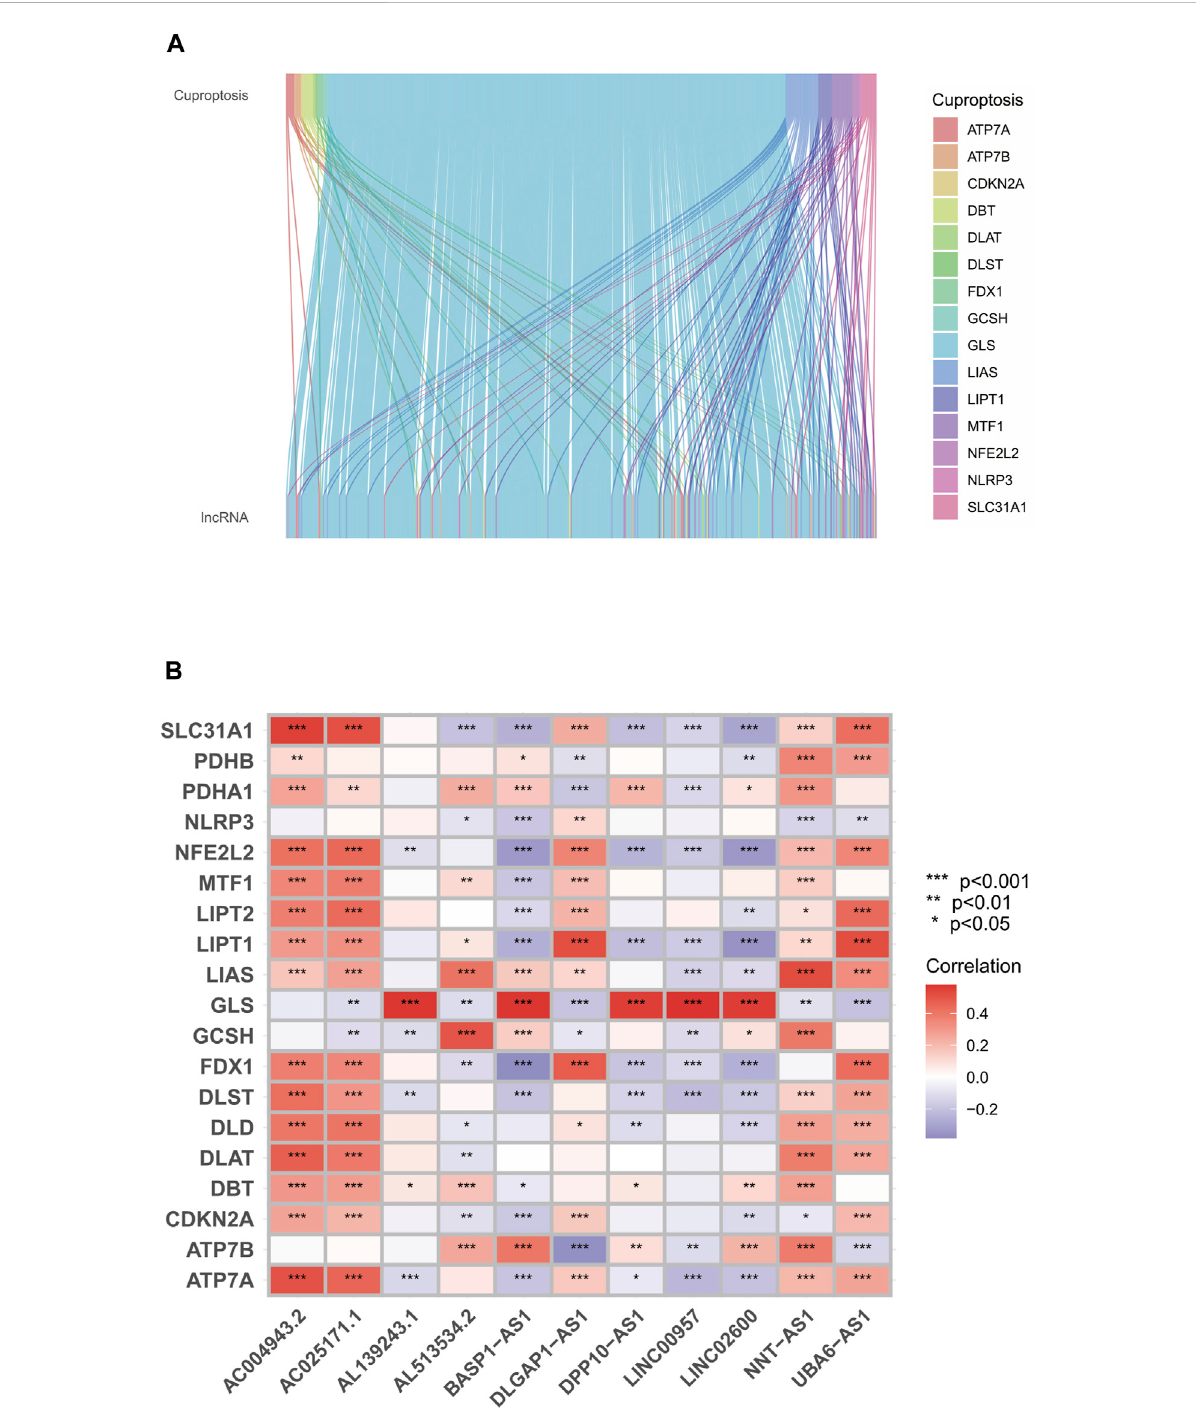
FIGURE 3 Relationship between GLS genes and copper death-related lncRNAs. (A) Sankey diagram of co-expression relationship between cuproptosis- related genes and lncRNAs. (B) Heat map of copper death-related genes and lncRNA correlation. *** p < 0.001, ** p < 0.01, * p < 0.05. Abbreviation: GLS,